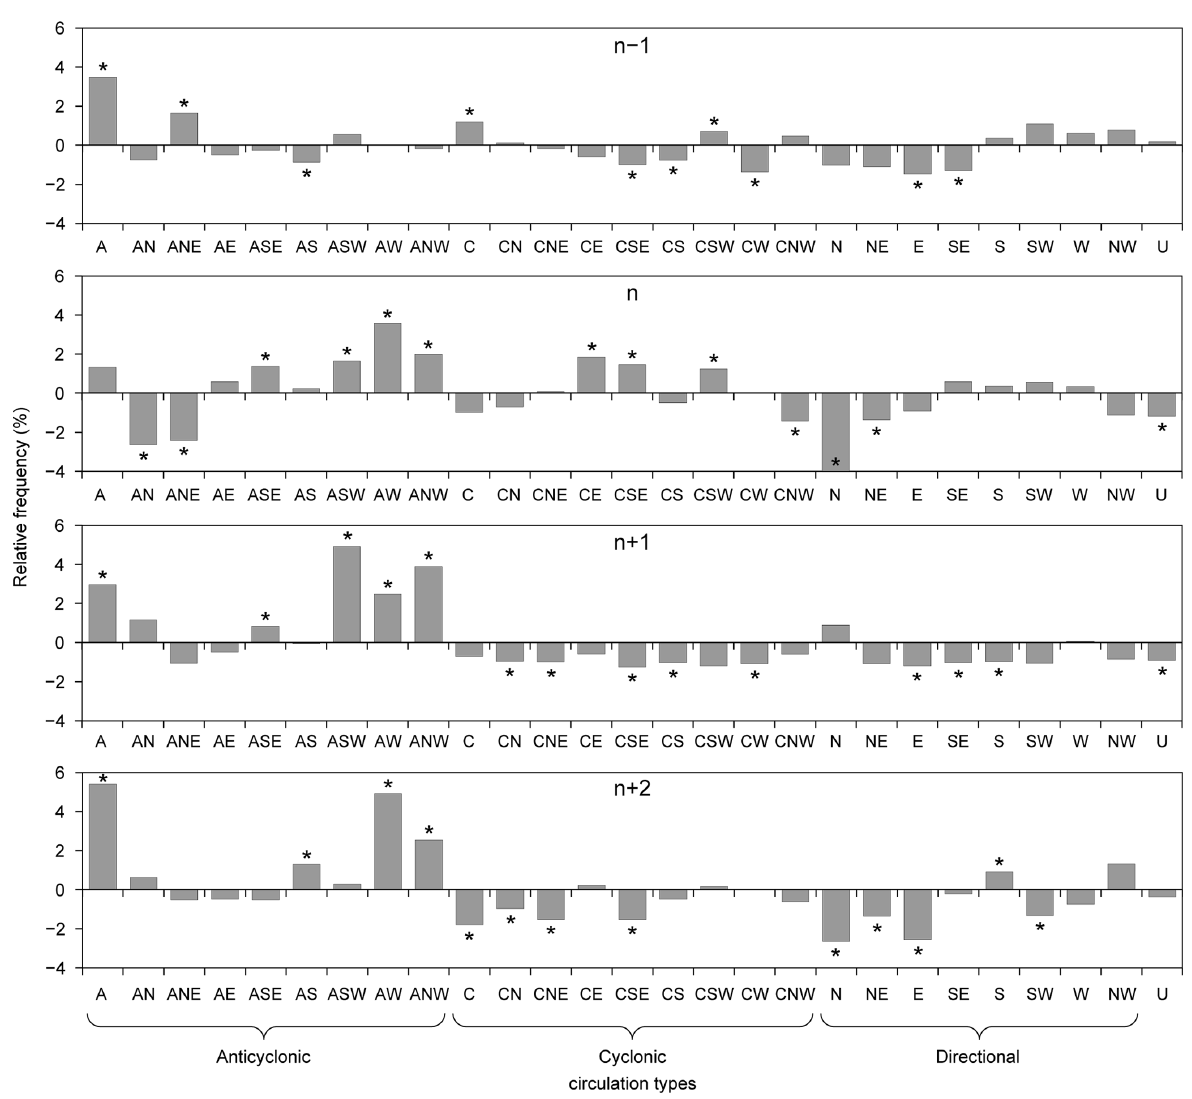
Figure 12. Differences in mean relative frequencies of individual circulation types of the objective classification in a composite of summers related to four bark beetle outbreaks from the 1980s (1982–1987, 1992–1995, 2007–2010, 2015–2021) and mean relative frequencies of the 1961–1990 reference period in the Czech Republic: n − 1 – a year before the first year of a bark beetle outbreak ( n ) and 2 years n + 1 and n + 2 after the first year n . Symbol * indicates statistically significant